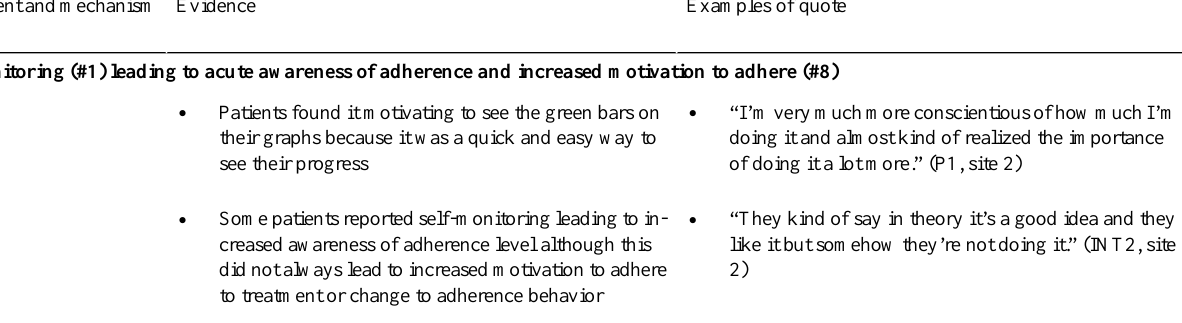
Table 3. Description of how behavior change components and mechanisms of action worked in the intervention. of